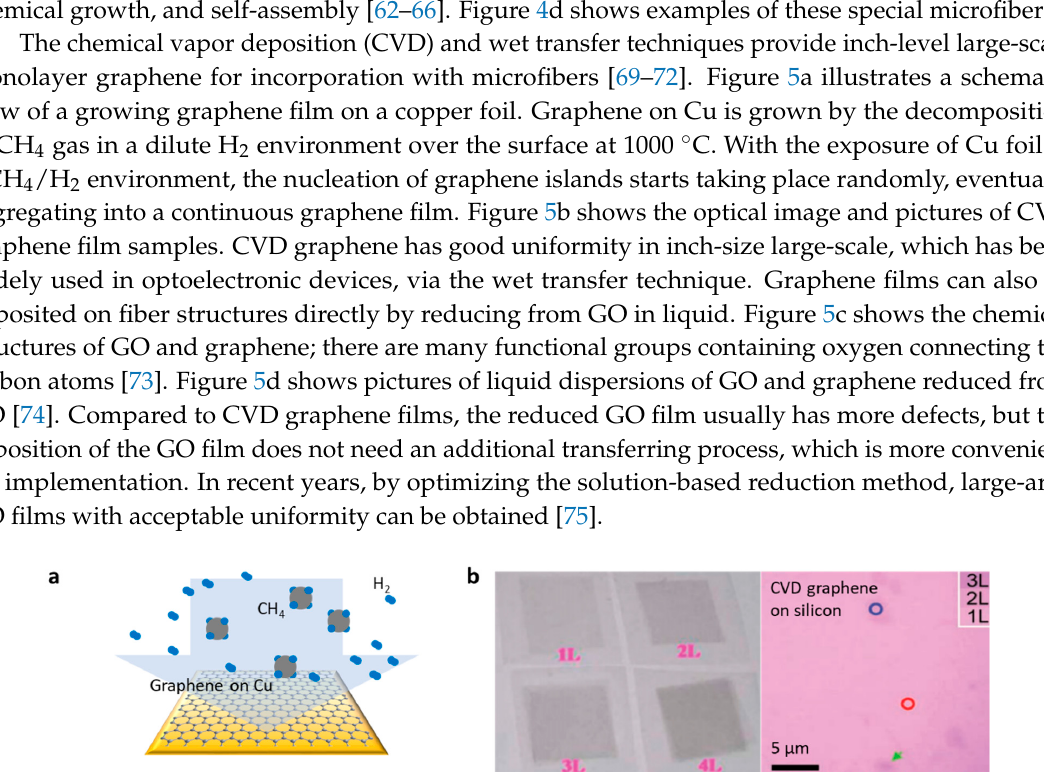
layer of polymethyl methacrylate (PMMA) on the surface of the graphene, forming the PMMA/graphene/Cu sandwich-like hybrid; dissolving the Cu under graphene by using FeCl 3 solution; covering the PMMA/graphene flexible film on a substrate or wrapping it on a microfiber; removing the PMMA by using acetone, leaving only graphene remaining.